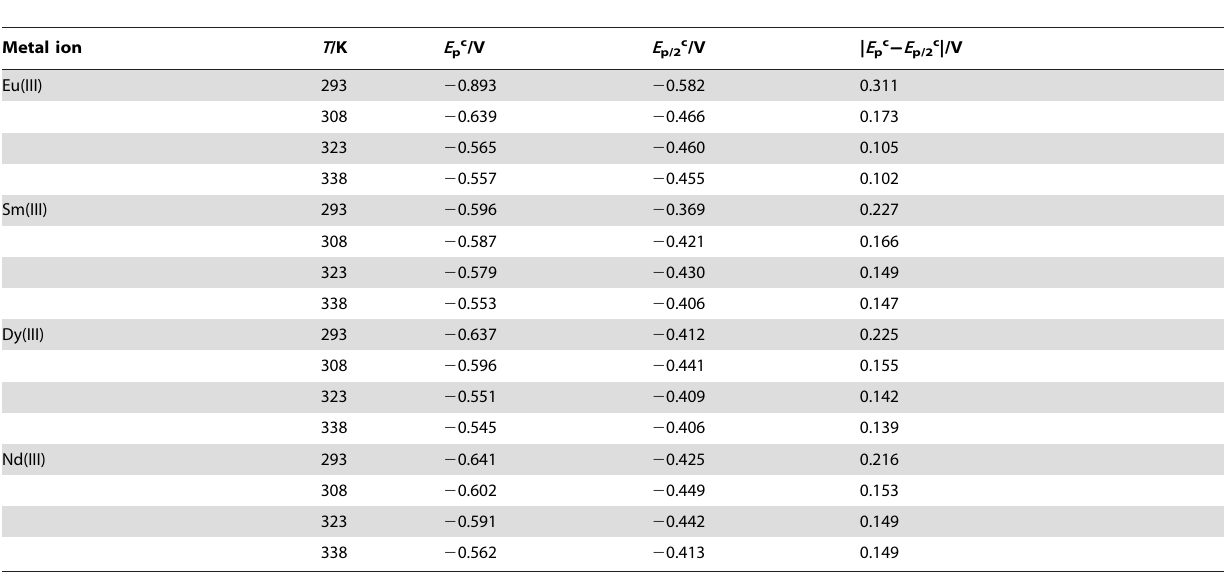
Table 1. Peak potentials E pc , E p/2c and | E pc 2 E p/2c | of Eu(III), Sm(III), Dy(III) and Nd(III) in BmimBr at different temperatures.